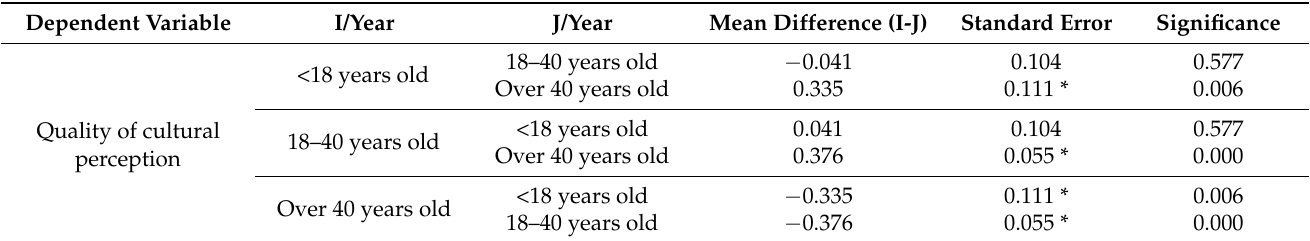
Table 4. One-way ANOVA test for the effect of age on perceived quality of culture (N = 417).